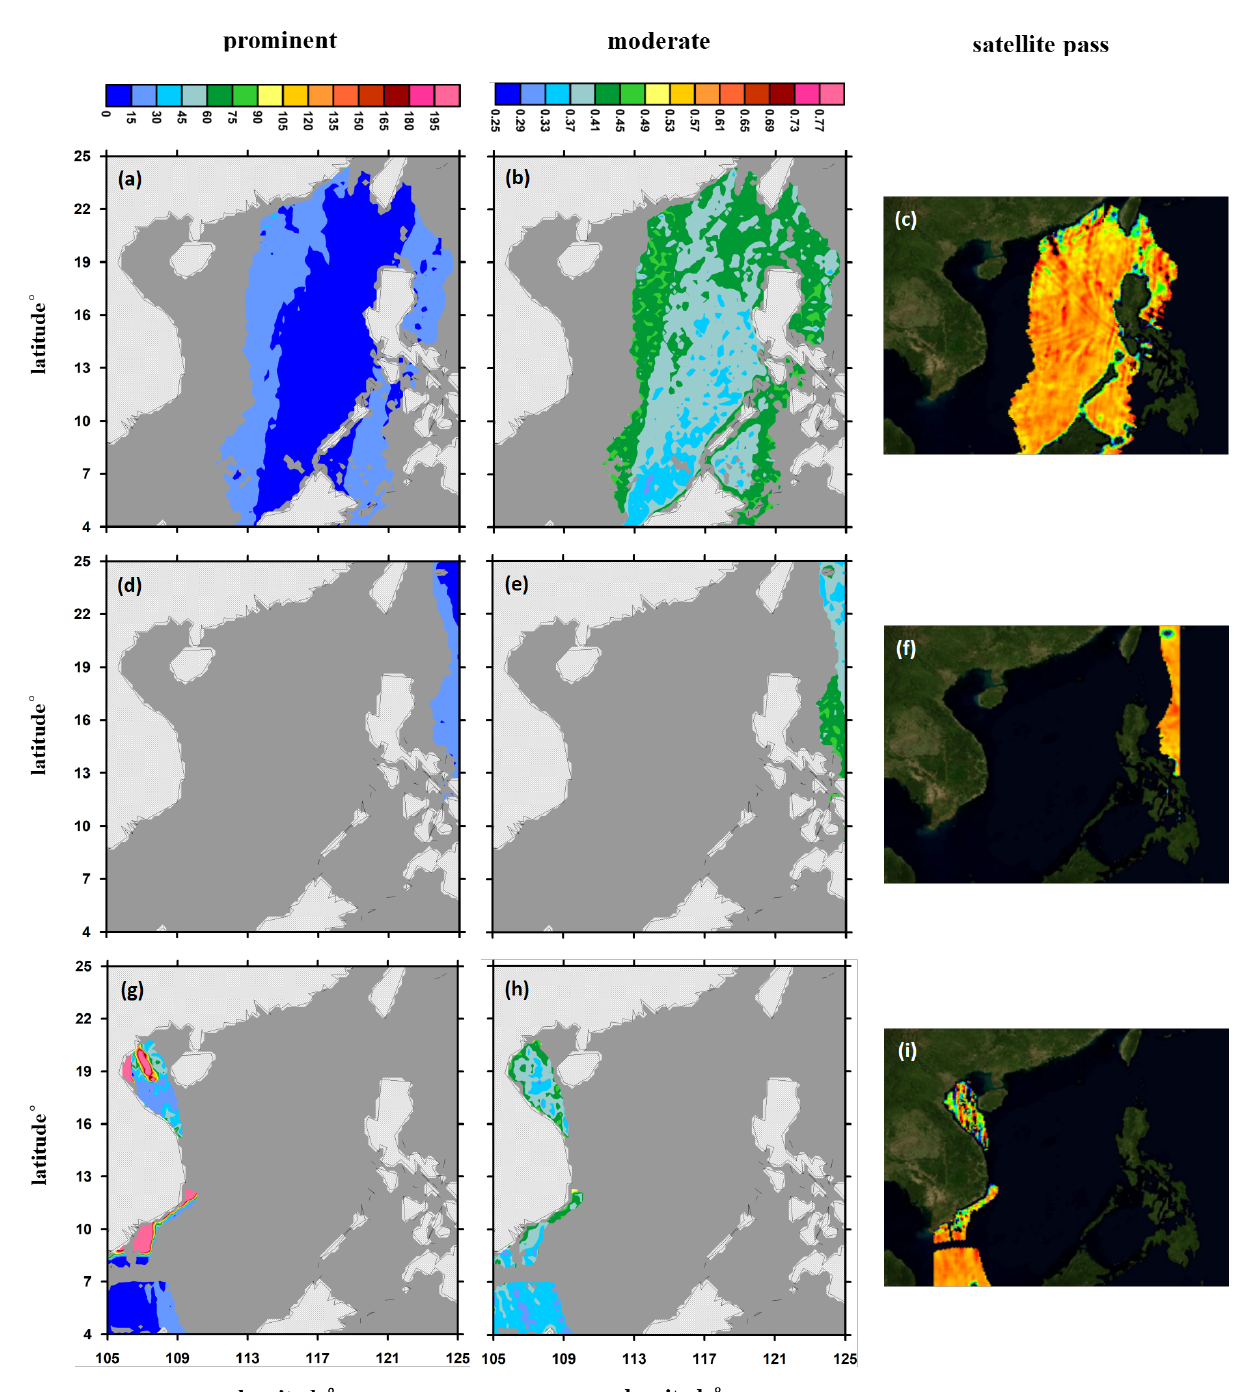
Figure 6. The separated RFI map. The prominent RFI maps ( a , d , g ) and the moderate RFI maps ( b , e , h ) are built on three SMOS passes on 15 January 2018. ( c , f , i ) are corrected SSS of these passes provided by ESA SMOS team, ( c ) corresponded to ( a , b ) which was taken on 15 January 2018 from 09:53:49 to 10:47:04, ( f ) corresponded to ( d , e ) which was taken on 15 January 2018 from 20:44:14 to 21:37:33, and ( i ) corresponded to ( g , h ) which was taken on 15 January 2018 from 22:24:19 to 23:17:37. All images have been truncated into SCS region. The light gray in the images represents the land area, and the dark gray is the area that was not covered during the discussed satellite